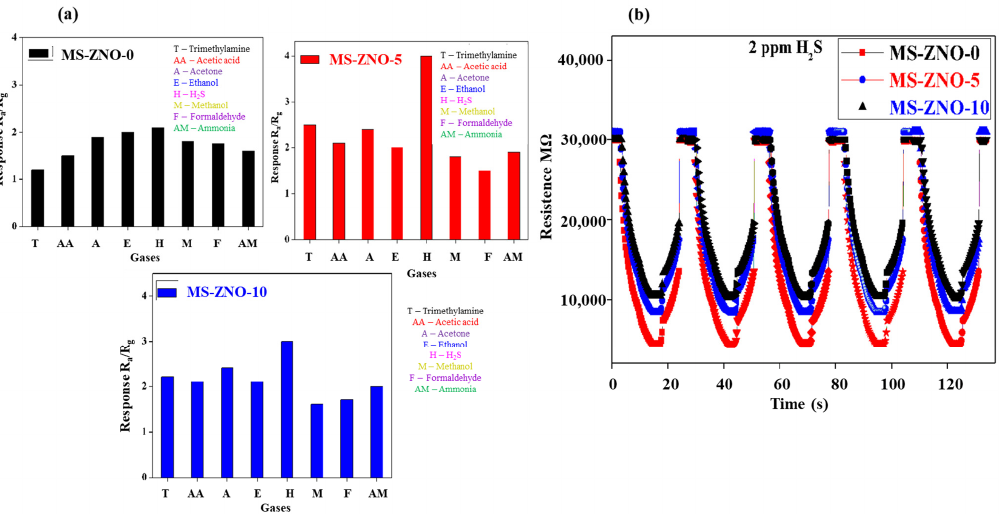
Figure 6. ( a ) Responses of MS-ZNO-0, MS-ZNO-5 and MS-ZNO-10 towards different gases (2 ppm); ( b ) reproducibility graphs of MS-ZNO-0, MS-ZNO-5 and MS-ZNO-10.